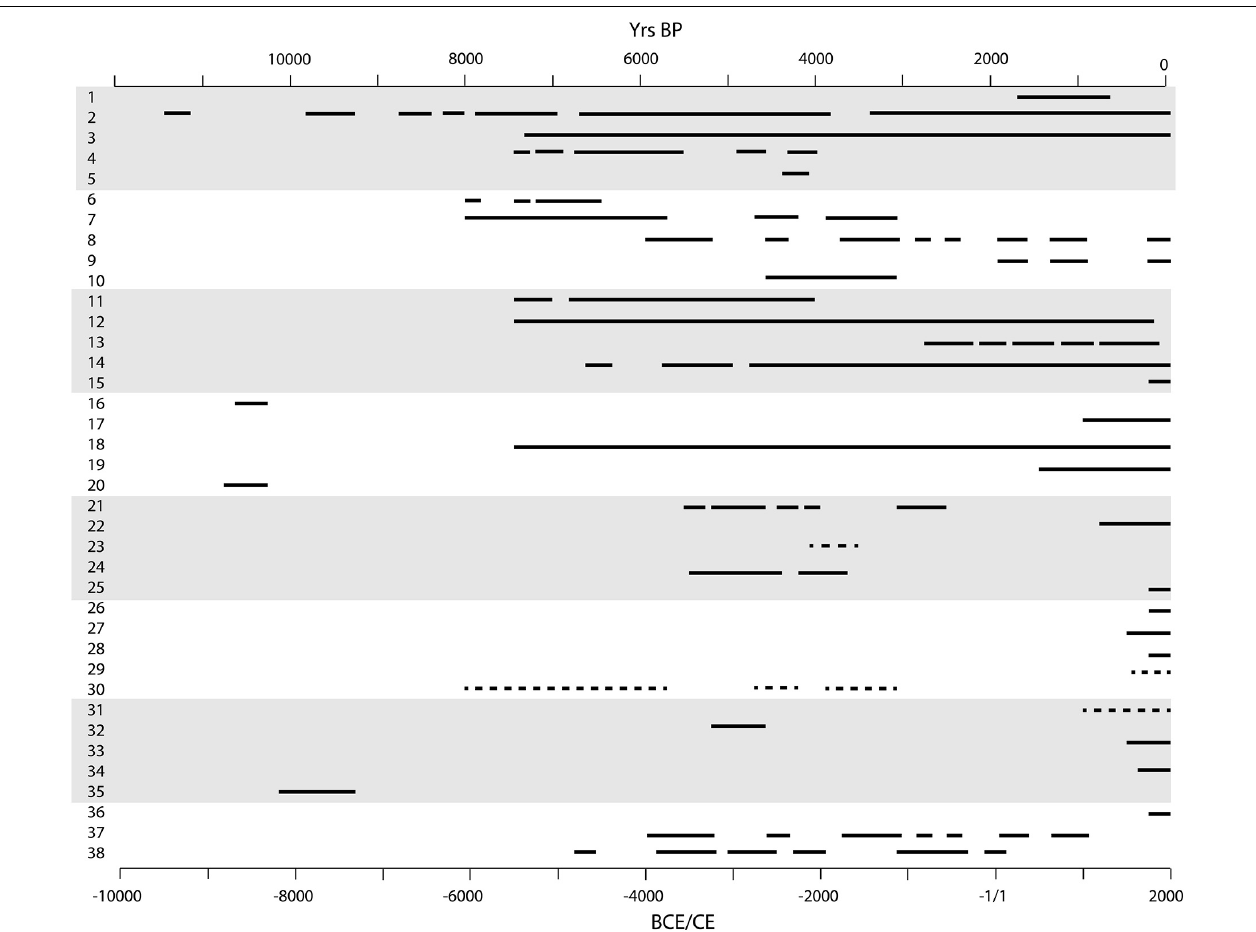
FIGURE 3 | The black lines show the main periods covered by the tree-ring data presented in the 38 reviewed studies (see Table 1 ). The dashed lines show periods tree-ring data used, but not presented in the studies covers. For most of the studies the paleobotanical data covers longer, sometimes significantly longer, periods. The figures correspond to those in Table 1 and Figure 2